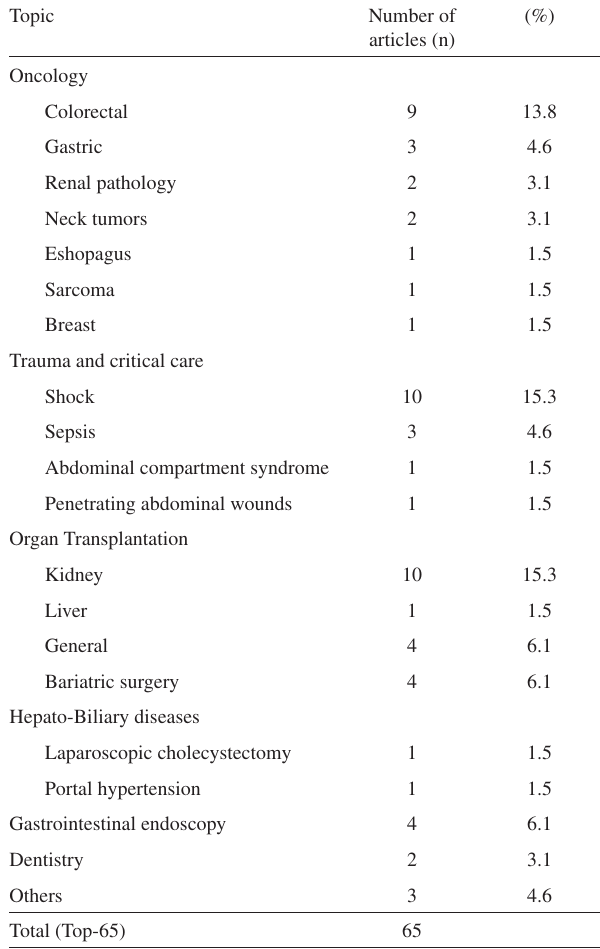
Figure 1 - Number of Brazilian articles published in The General Surgery Journals, during the period of 1970-2009.